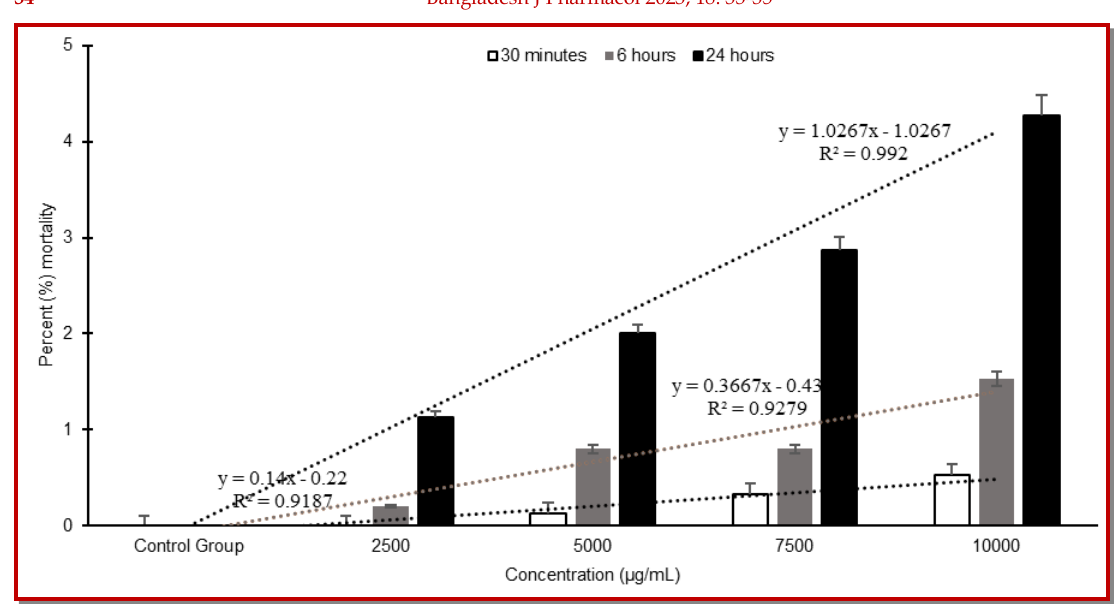
Figure 1: Percent mortality of brine shrimps at a different time of exposure to C. Molle leaf aqueous extract correlation coefficient of the logarithm of the C. molle extract concentrations to the percent mortality of the brine shrimps indicated that as the concentration of C. LC 50 of C. Molle at different time of exposure Length of exposure LC 50 Confidence interval (hour) (µg/mL)